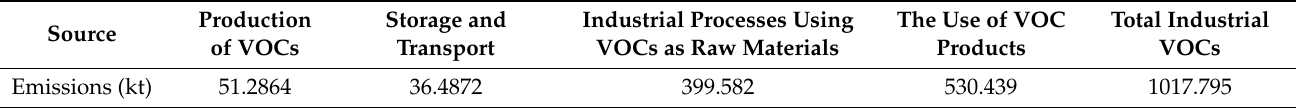
Table 6. VOC emissions from four types of industrial sources in Hebei Province in